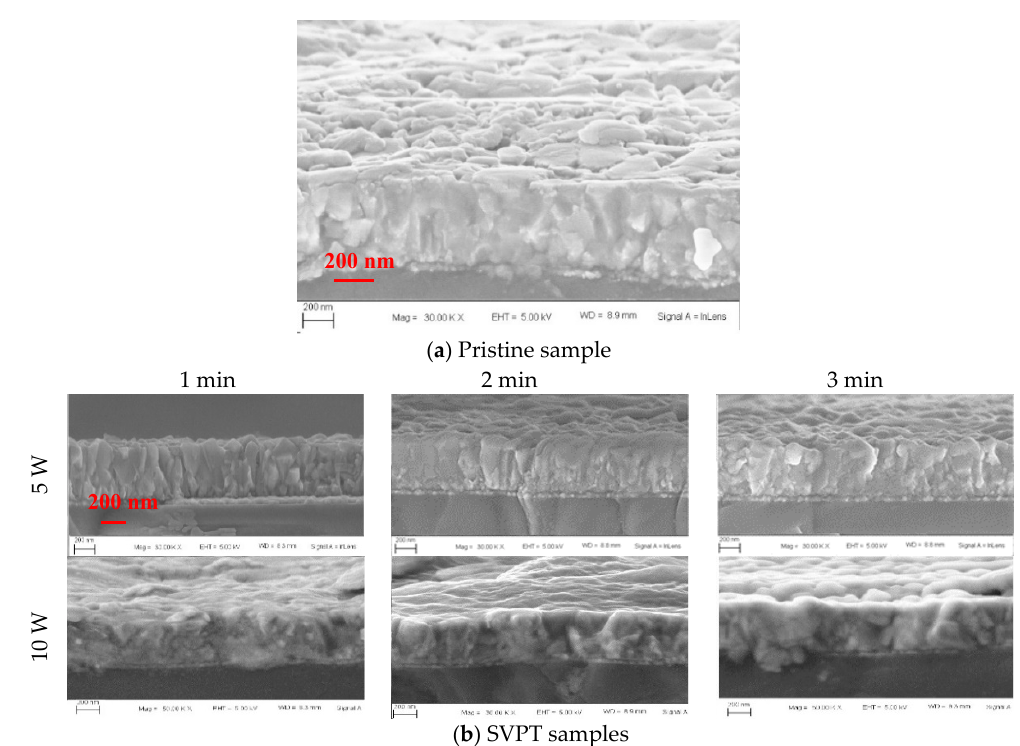
Figure 3. Cross-sectional SEM images of ( a ) pristine PbI 2 thin films and ( b ) thin films subjected to the SVPT. All images have the same magnification and scale bar.